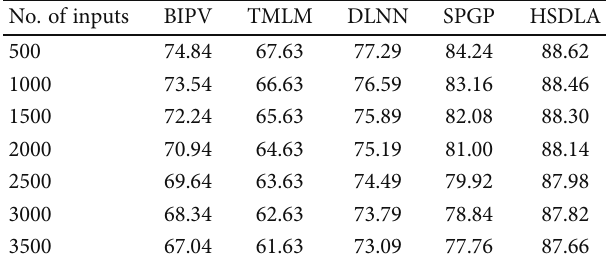
Table 3: Exhaust-tube solar